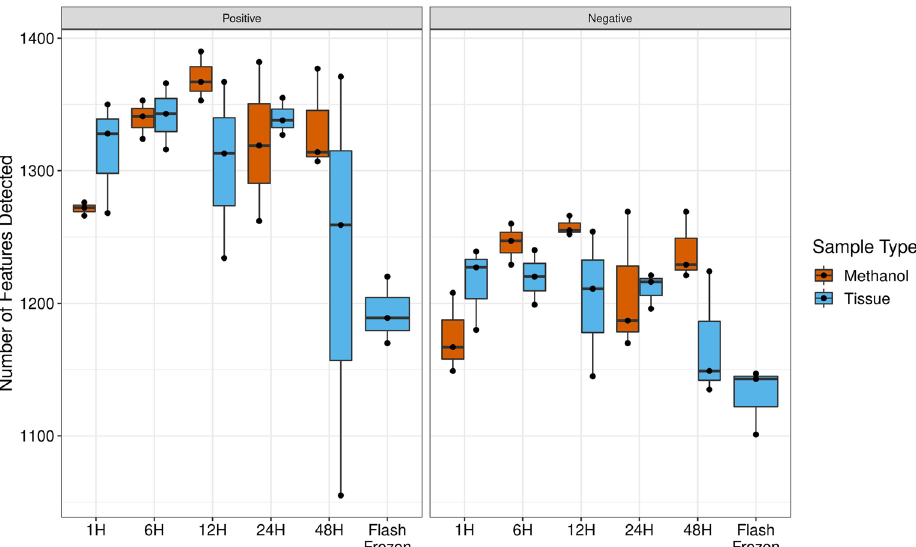
Figure 1. Number of metabolite features detected in positive and negative ion mode by sample type (tissue or methanol extract) and methanol fixation time. H hours.